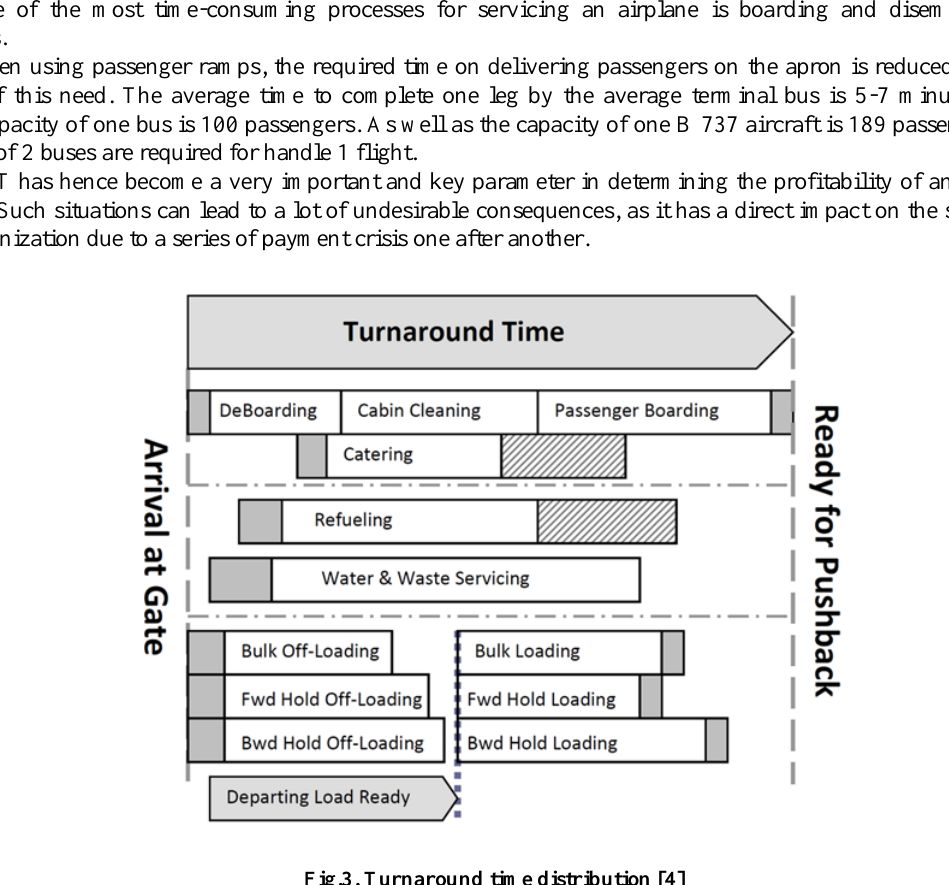
Fig.3. Turnaround time distribution